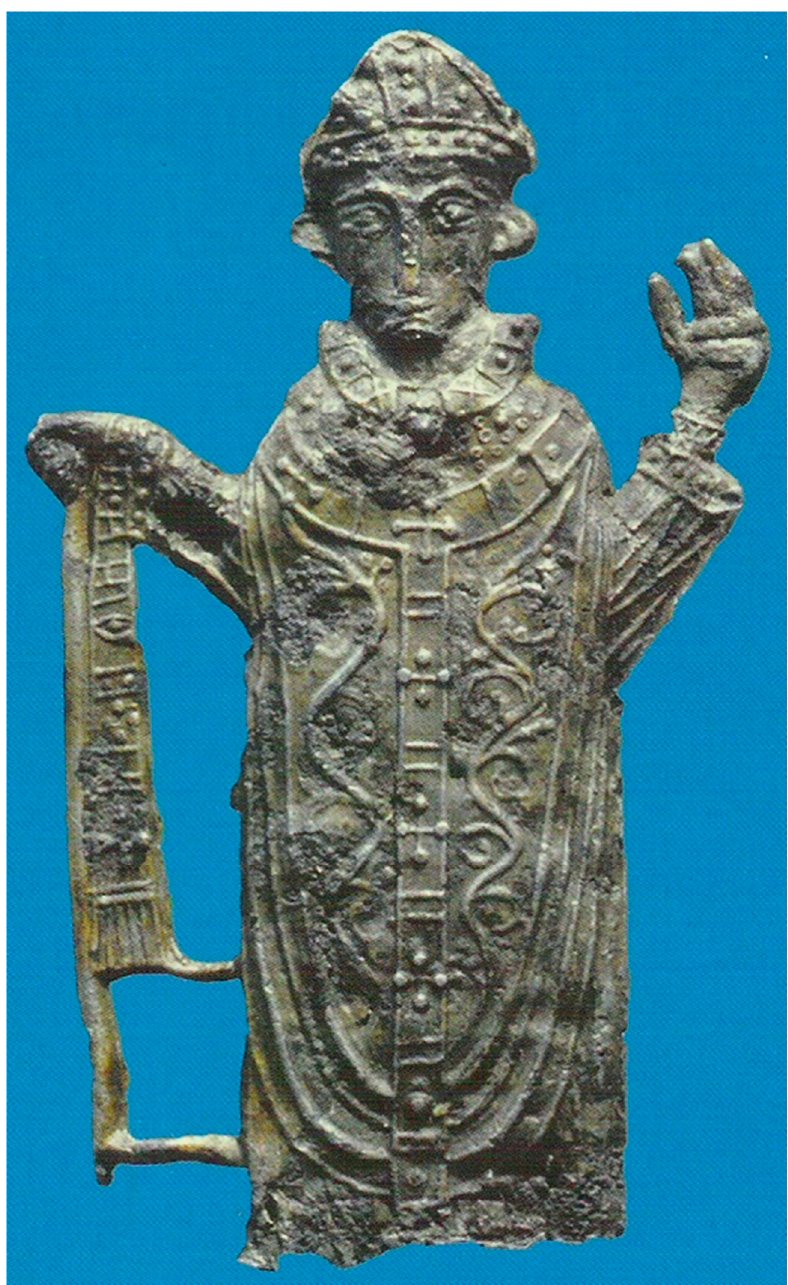
Figure 6. Hollow-cast figure of St. Thomas Becket, Canterbury, late 13th / early 14th century. Formerly Collection of Brian North Lee. Photo: Author.